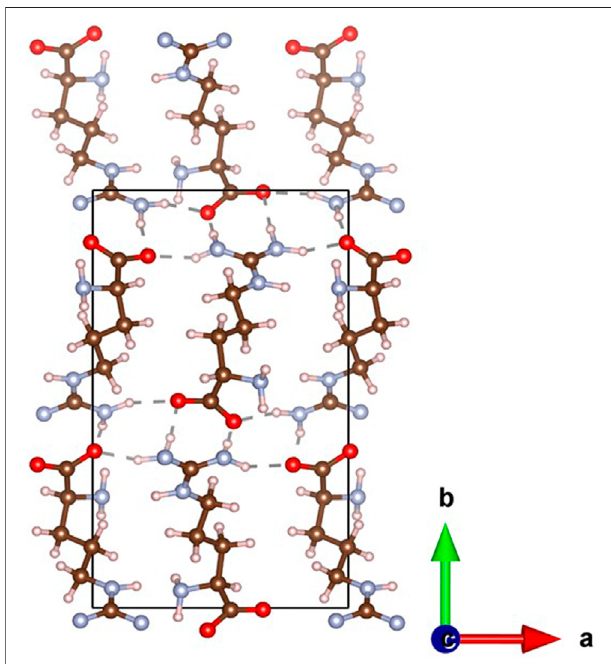
FIGURE 1 | Crystal structure of L-Arginine, with molecules shown in CPK representation. Nitrogen atoms are coloured red, carbons are brown, hydrogens are white, and nitrogens are blue. Intermolecular hydrogen bonds are shown in dark grey.